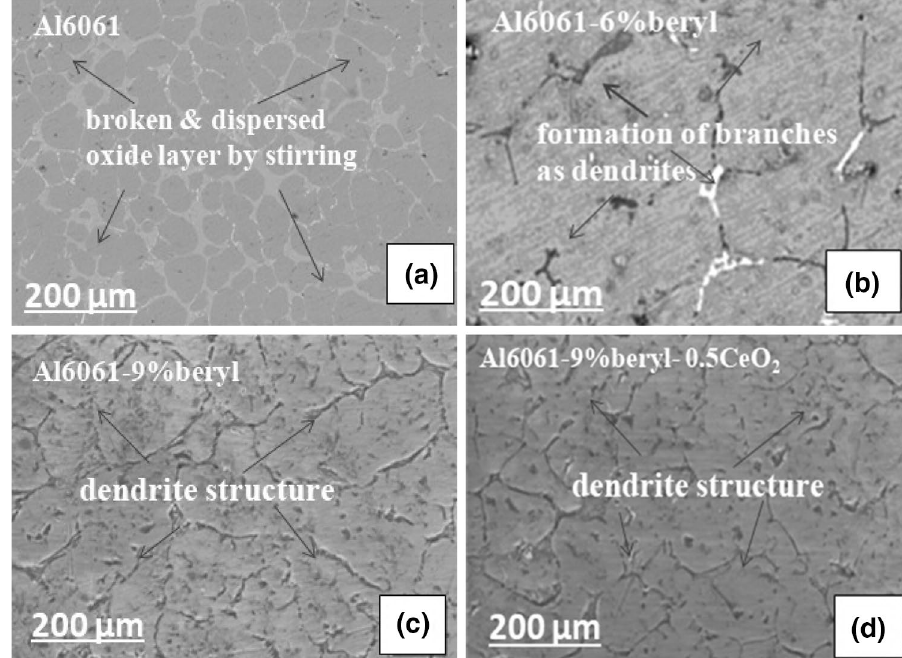
Fig. 3 Representative micro‑ scopic images of ( a ) “ as casted ” Al6061, ( b ) “Al6061–6% Beryl,” ( c ) “Al6061–9% Beryl” and ( d